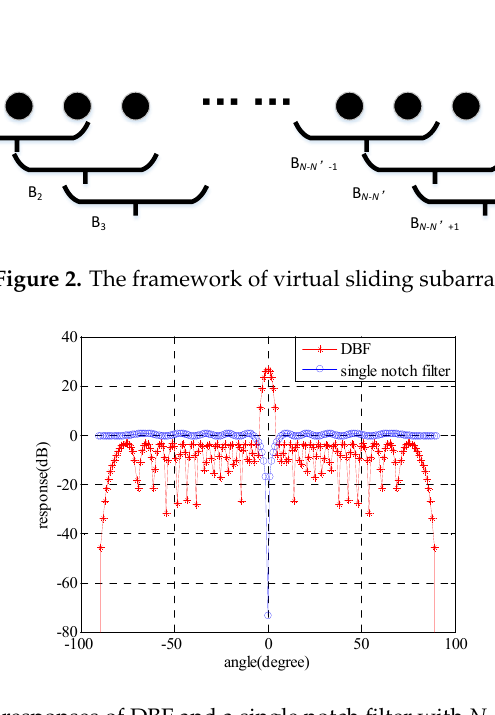
Figure 3. Space responses of DBF and a single notch filter with N = 32 and N ’ = 12